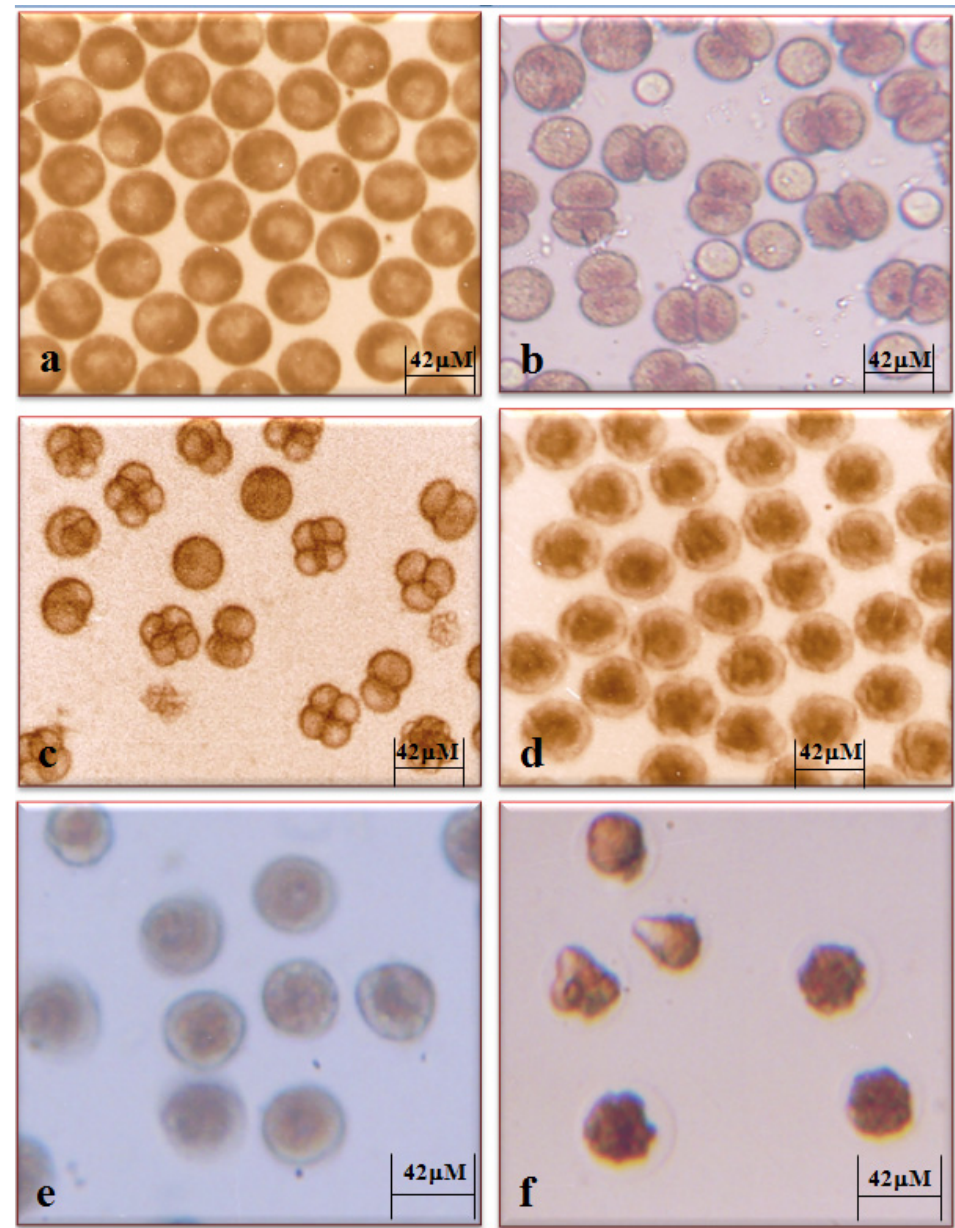
Figure 2. Delayed and abnormal development of embryos of H. elegans in sample water collected from different regions of southeast coast of India: ( a ) eggs before fertilization; ( b ) fertilized eggs and two-cell stage; ( c ) four-cell stage; ( d ) blastula stage; ( e ) deformed blastula stage when the eggs were exposed to station 2 (Royapuram) seawater; ( f ) deformed embryonic development when the sperm were exposed to station 1 (Ennore)